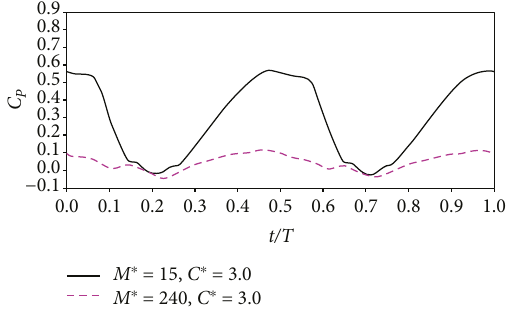
Figure 15: The time variation of power coe ffi cient of the considered cases with M ∗ = 15 , C ∗ = 3 0 and M ∗ = 240 , C ∗ = 3 0 . Figure 16: The time variation of h